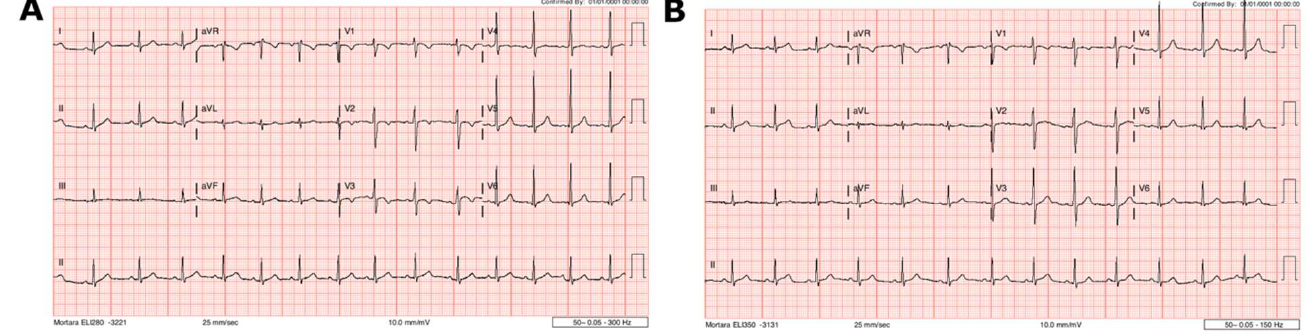
Figure 1. Case 1 ECG findings. ( A ) ECG at presentation demonstrating abnormal repolarization, including T-wave inversion in V2–V3 and T-wave flattening in V4. ( B ) One month after presentation, showing resolution of these changes.